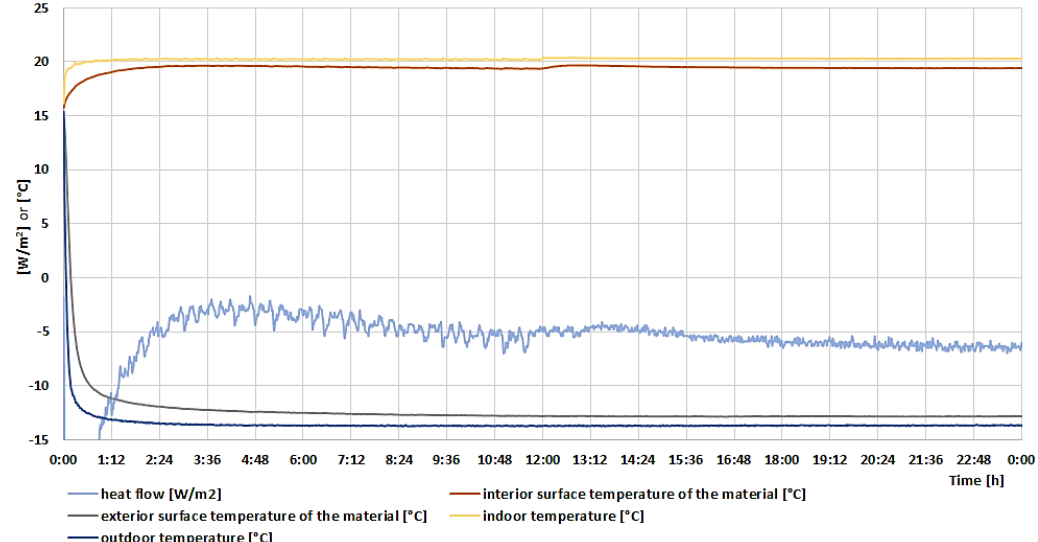
Figure 3. Development of the measured parameters during simulations—variant B.